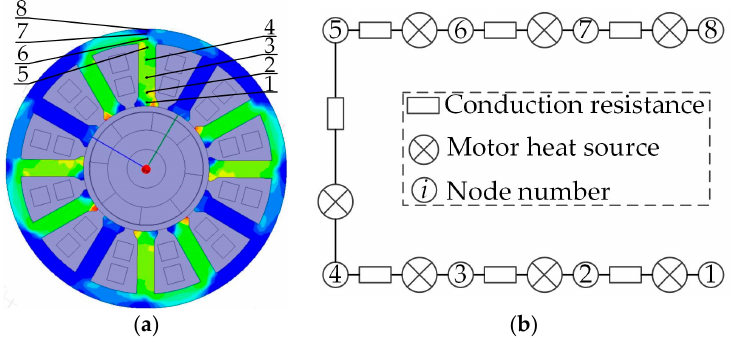
Figure 12. Optimization model of the motor stator. ( a ) Structure of the stator; ( b ) The refined thermal network model.